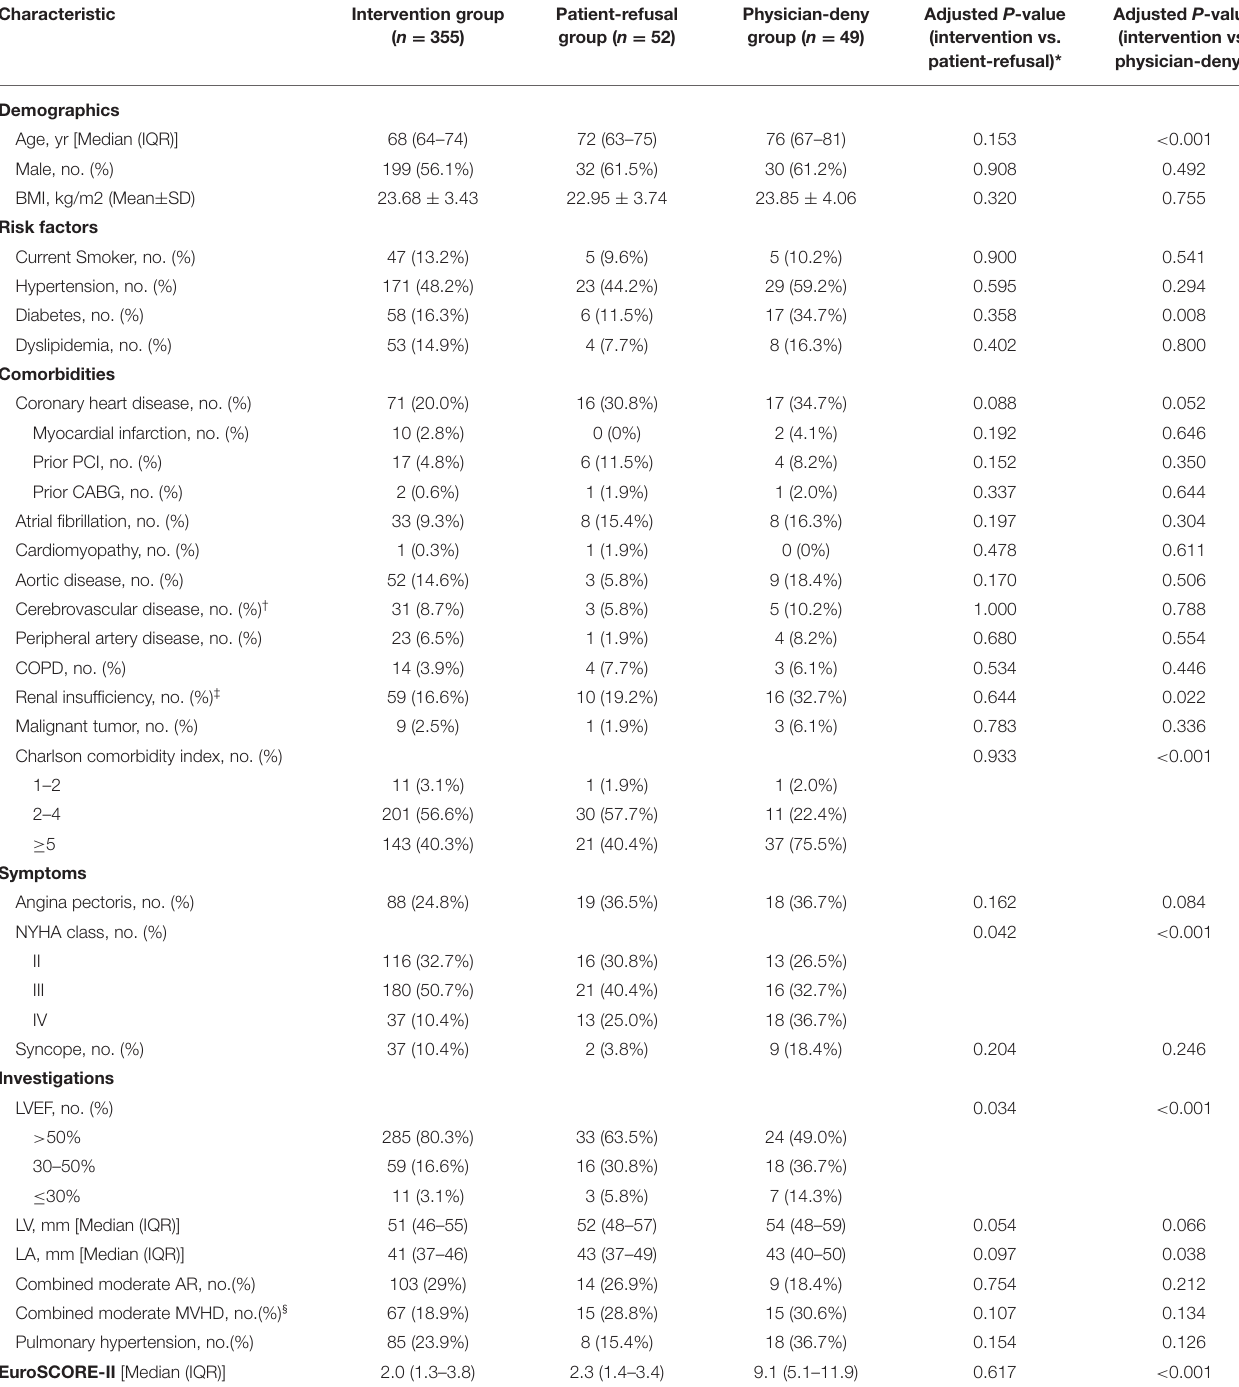
TABLE 1 | Baseline